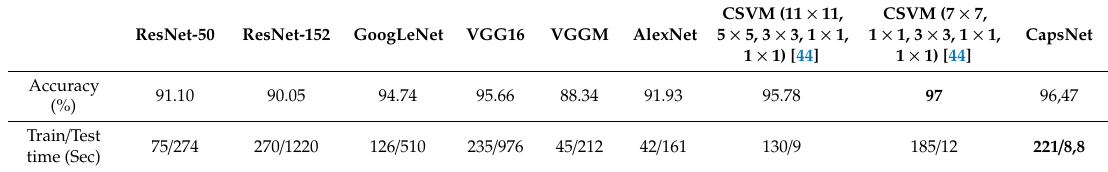
Table 10. Comparison with the state-of-the-art on the Car dataset.